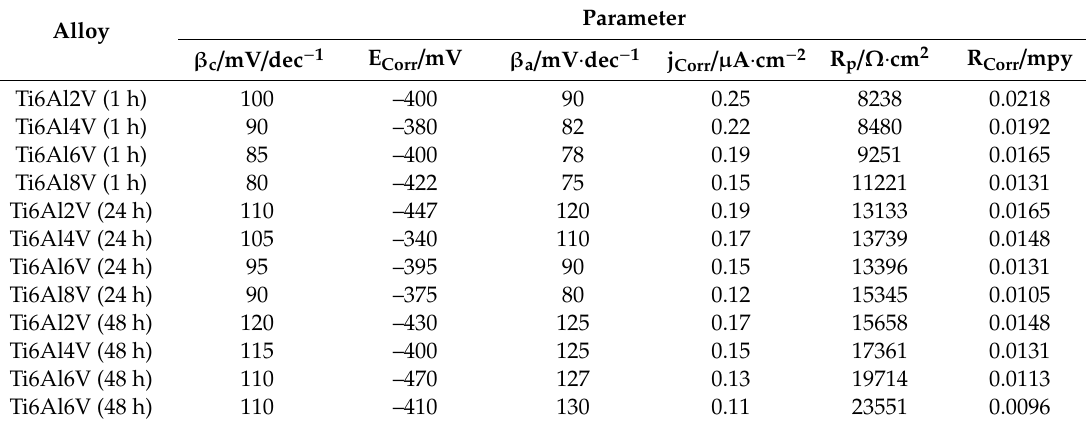
Table 1. Impedance data collected for the tested Ti alloys at the different conditions.